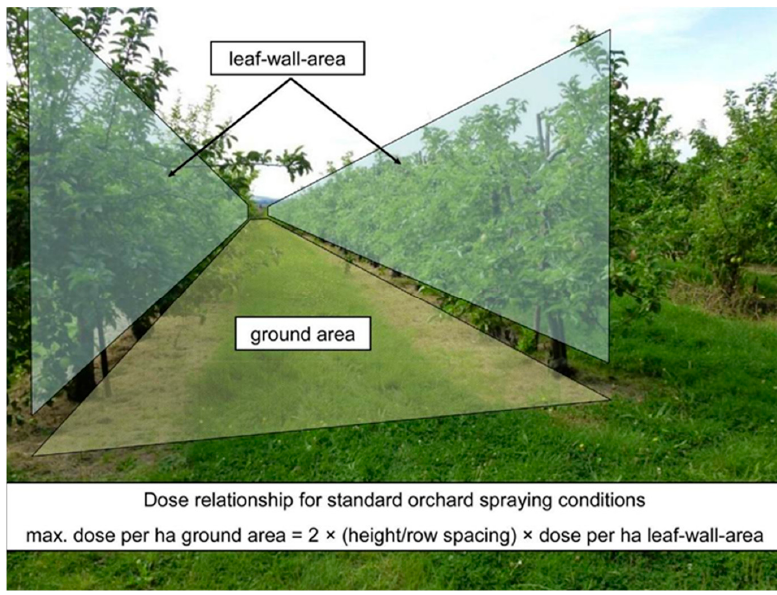
Figure 11. Relationship between LWA and GA [104].